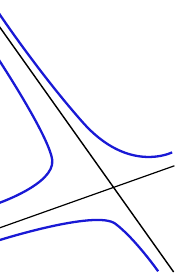
Figure 2. Graphical representation of a polynomial saddle phase